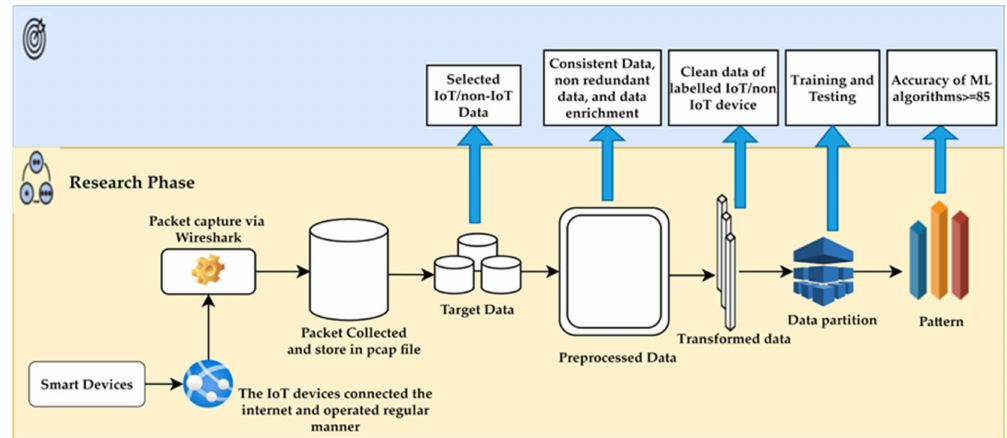
Figure 5. Proposed machine learning based traffic classification